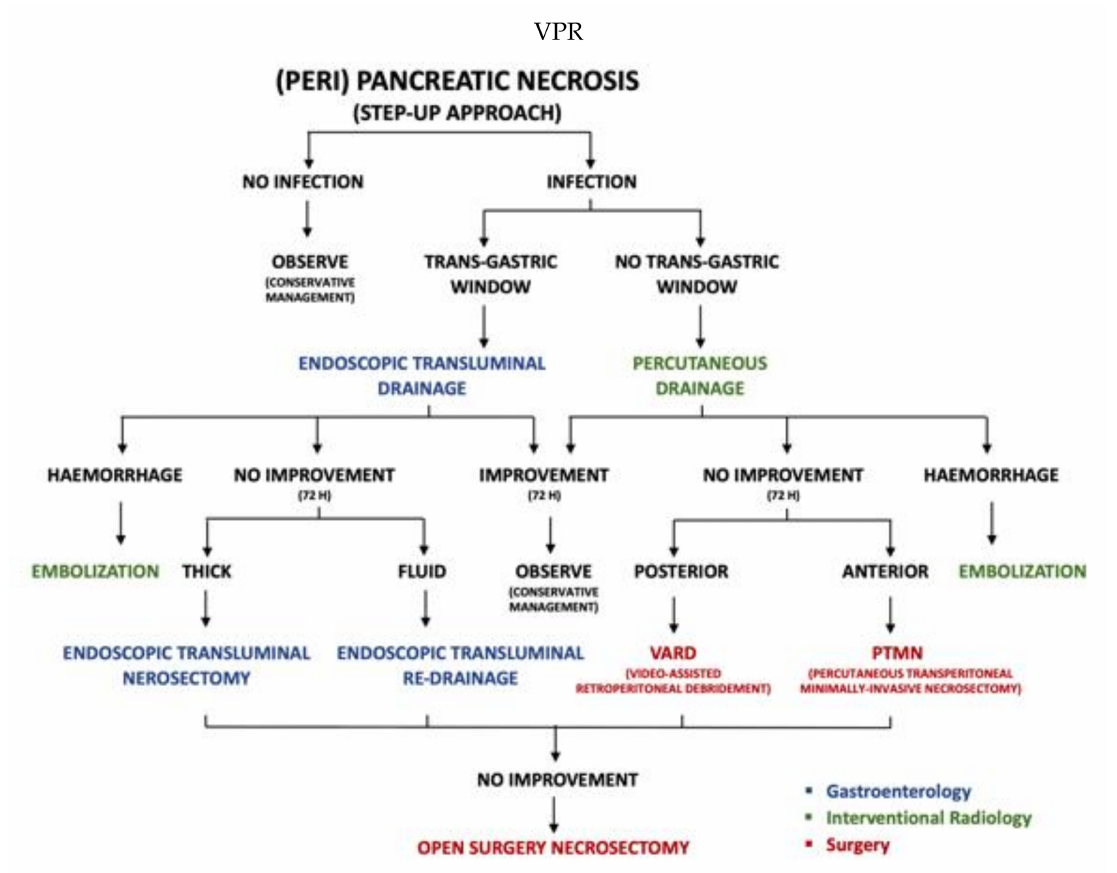
Figure 2. Pathways of management of complicated acute pancreatitis. Types of interventions are di ff erentiated by colors: Surgery in red, gastroenterology in blue, interventional radiology in